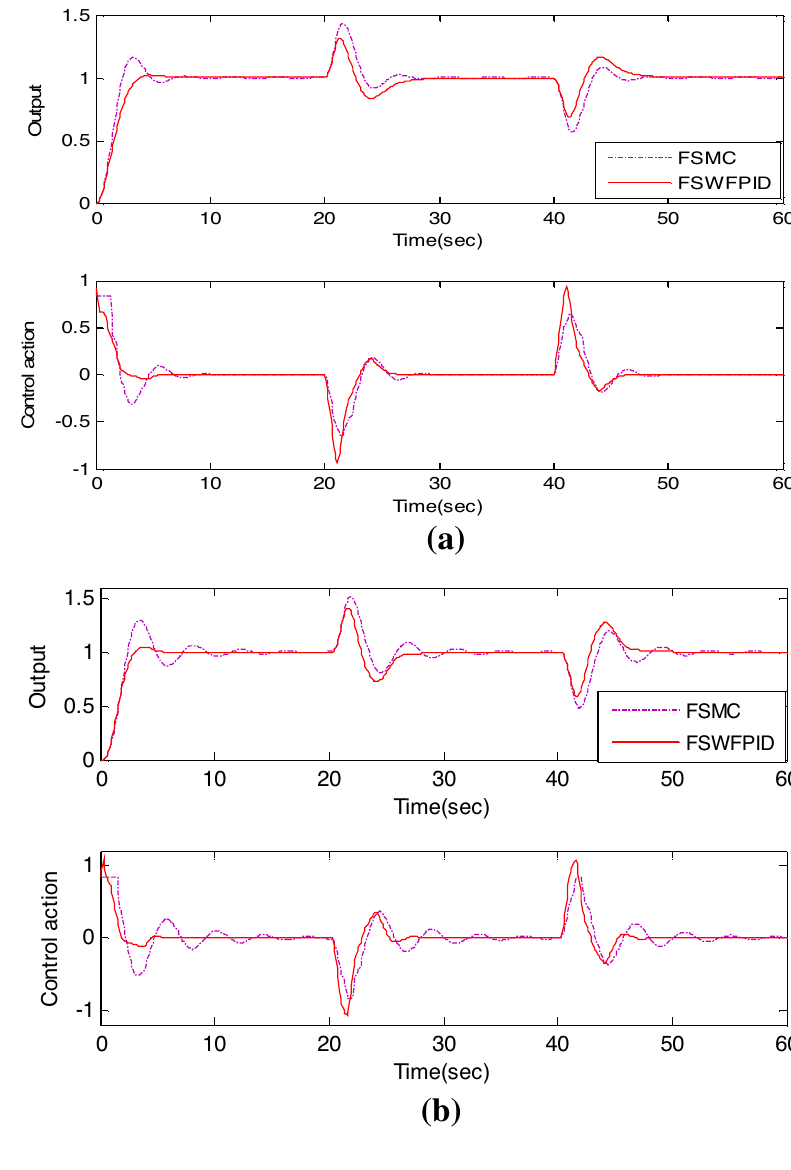
Fig. 8 Comparison among responses and control actions for Model I with FSMC using 25 rules during set point response and with load variation for a L = 0.05 s, b L = 0.3